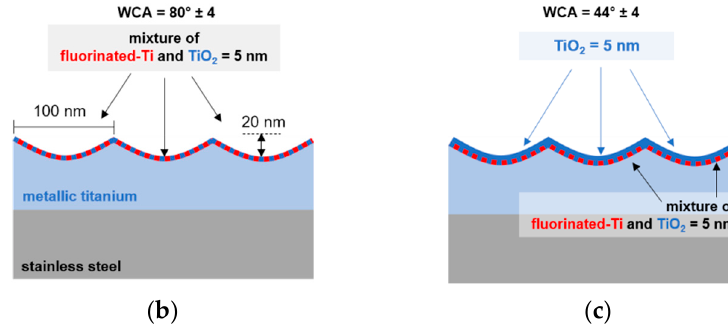
Figure 11. Schematic representation of the surface chemistry and morphology of ( a ) aTiO 2 , ( b ) cTi , and ( c ) cTi+P surfaces.